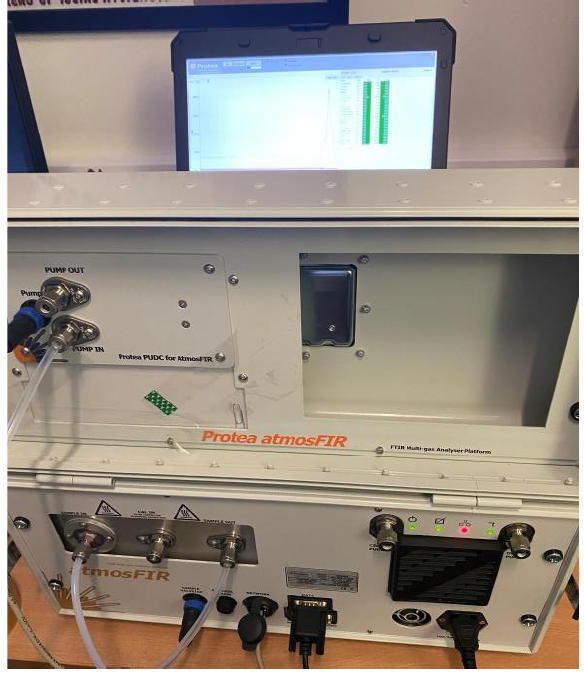
Figure 1. The Protea atmosFIR gas analyser.